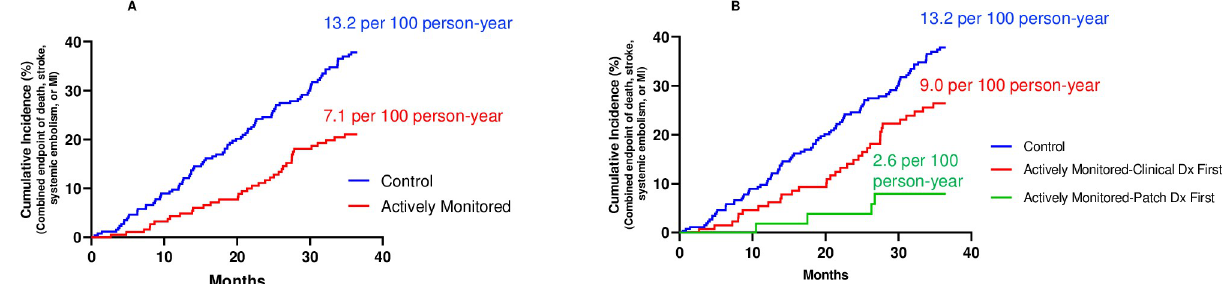
Fig 4. Primary endpoint in those receiving a new diagnosis of atrial fibrillation. Cumulative incidence of the combined primary endpoint in individuals diagnosed with atrial fibrillation in A.) the actively monitored and observational control cohorts, and B.) the actively monitored cohort based on whether their initial diagnosis of AF was via ECG patch screening or via a clinical diagnosis, and the observational control